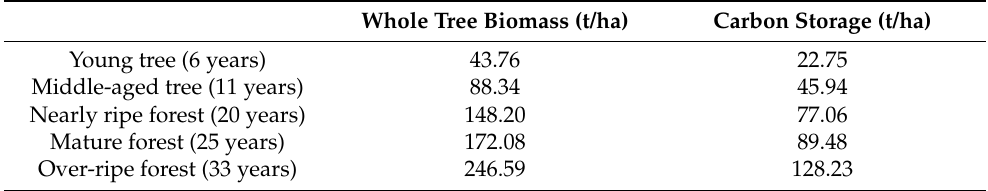
Table 1. Biomass and carbon storage of Taxodiaceae in different years [16]. Whole Tree Biomass (t/ha) Carbon Storage (t/ha) Young tree (6 years) 43.76 22.75 Middle-aged tree (11 years) 88.34 45.94 Nearly ripe forest (20 years) 148.20 77.06 Mature forest (25 years) 172.08 89.48 Over-ripe forest (33 years) 246.59